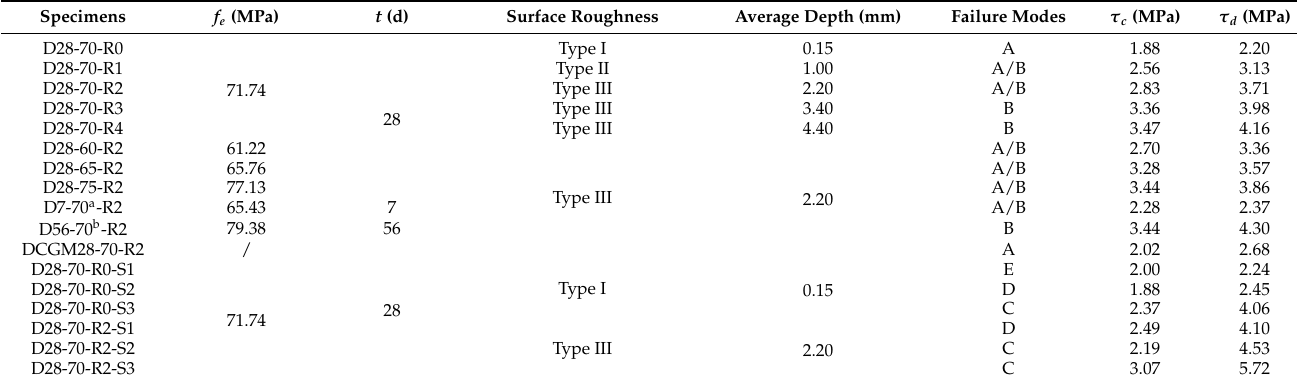
Table 5. Details of the